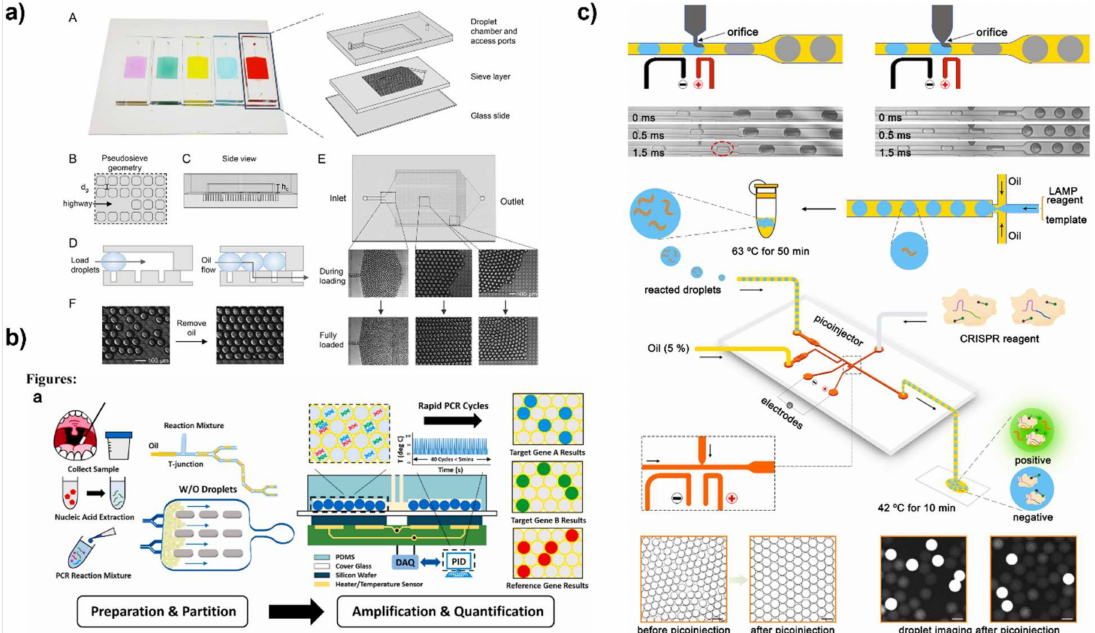
Figure 4. PDMS sieve trapping system for enhanced droplet loading. ( a ) Reprinted with permission from O’Keefe, C.; Kaushik, A.; Wang, T. Highly Efficient Real-Time Droplet Analysis Platform for High-Throughput Interrogation of DNA Sequences by Melt. Analytical Chemistry 2019 , 91 (17), Copyright 2019 American Chemical society [124]. ( b ) Multiplexed digital SARS-CoV-2 RNA detection using parallel droplet generation and color-coded fluorescence readout. Reprinted from Biosensors and Bioelectronics, Volume 188, Yin et al., “Ultrafast multiplexed detection system of SARS-CoV-2 RNA using a rapid droplet digital PCR system” p. 113282, Copyright 2021 with permission from Elsevier [126]. ( c ) Multistep digital LAMP and CRISPR microfluidic device for SARS-CoV-2 RNA detection. Reprinted from Biosensors and Bioelectronics, Volume 211, Wu et al., “DropCRISPR: A LAMP-Cas12a based digital method for ultrasensitive detection of nucleic acid” p. 114377, Copyright 2022 with permission from Elsevier